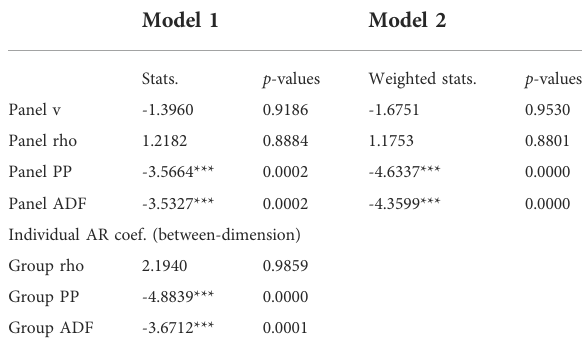
TABLE 4 Unit root results CADF test.